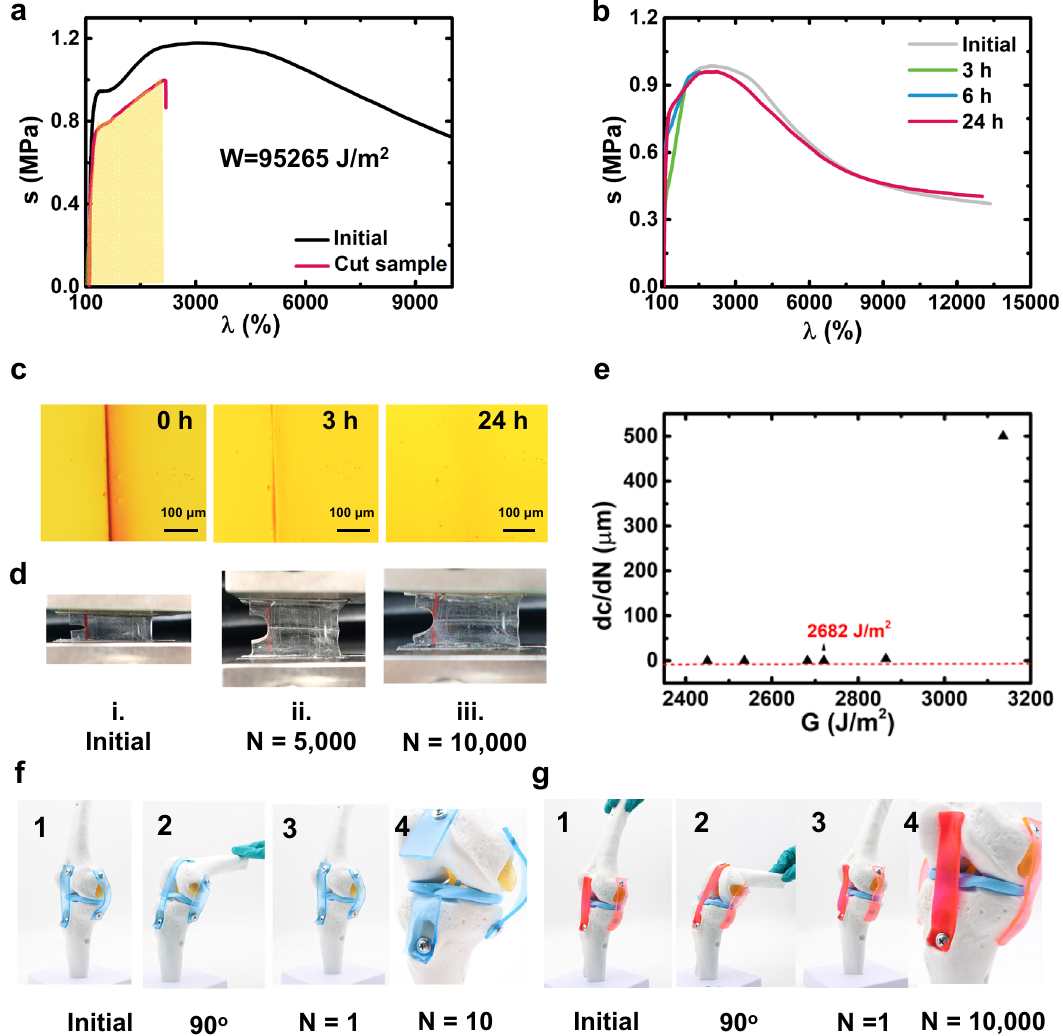
Fig. 4 Toughness and anti-fatigue properties. a Fracture energy of MEG2-Li. b Stress-strain curves of original and healed specimens for different healing times at room temperature. c Optical microscope images of a cut MEG2-Li specimen healing for various times at room temperature. d Photos of the initial notched specimen ( N = 1, λ = 100%) (i) and the notched specimen after 5,000 cycles (ii) ( N = 5,000, λ = 337.5%) and after 10,000 cycles (iii) ( N